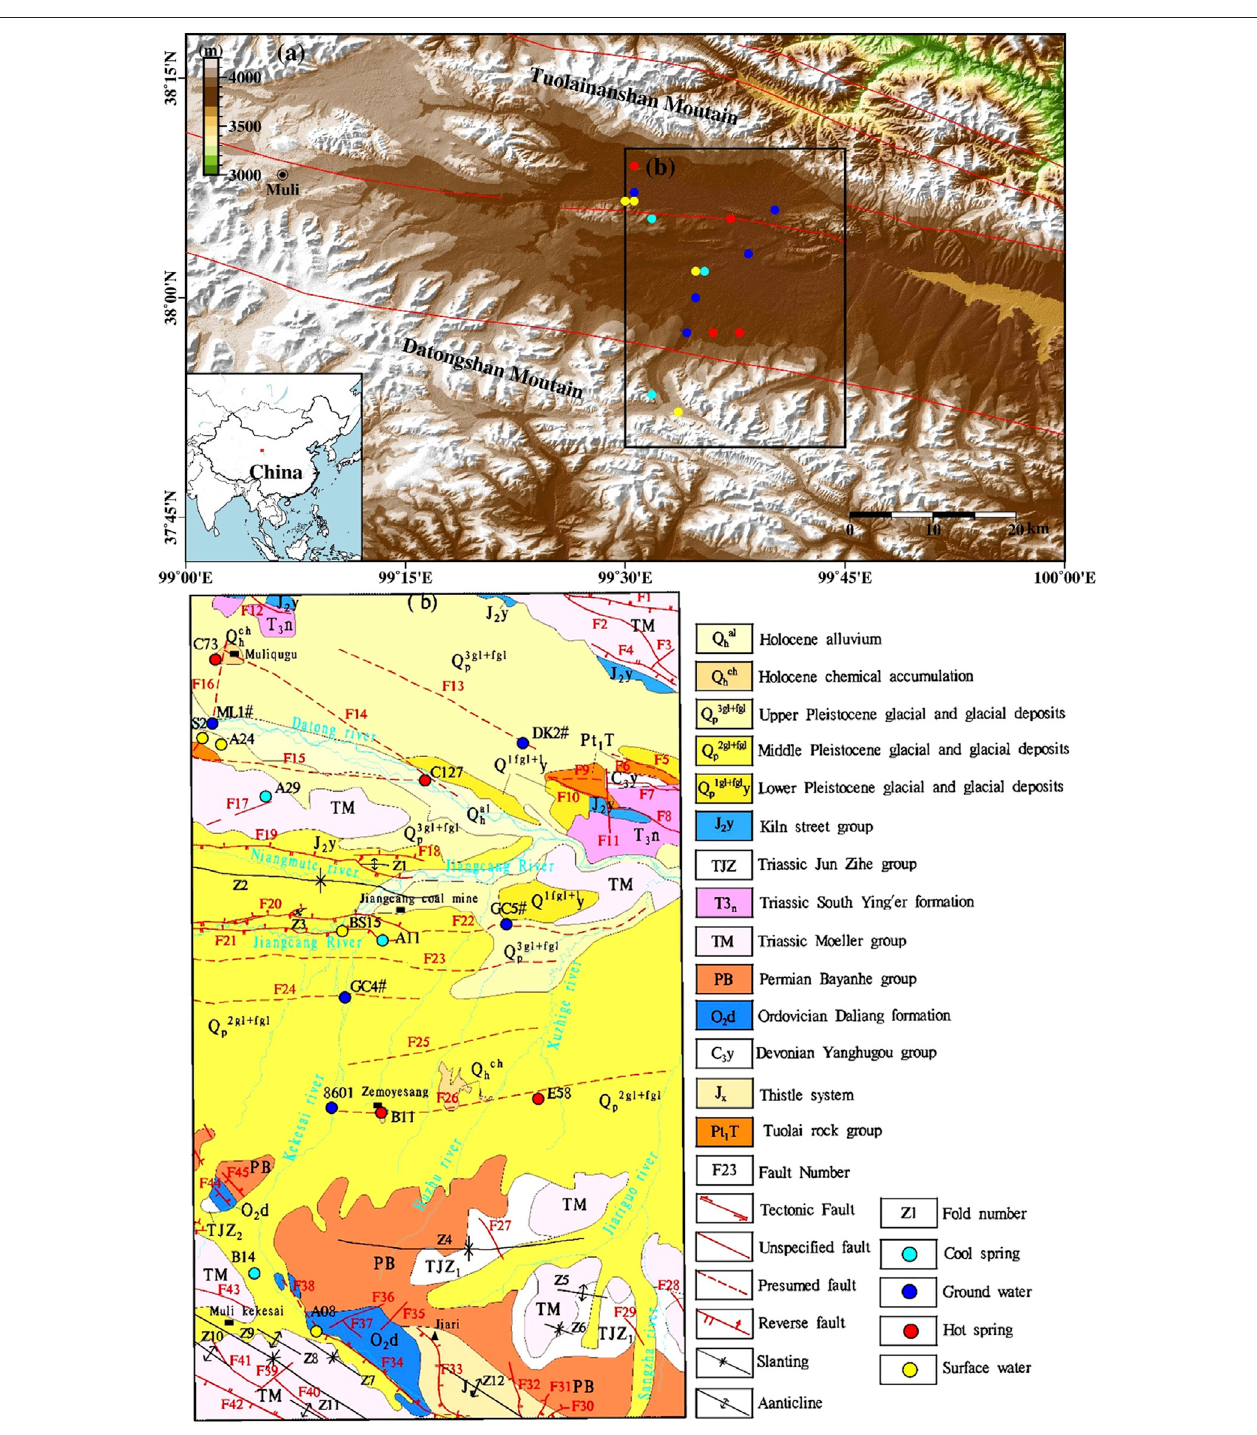
FIGURE 1 | (A) Geological sketch and sampling point location map of the study area. (B) After hydrogeological and environmental geological survey of Qinghai energy.